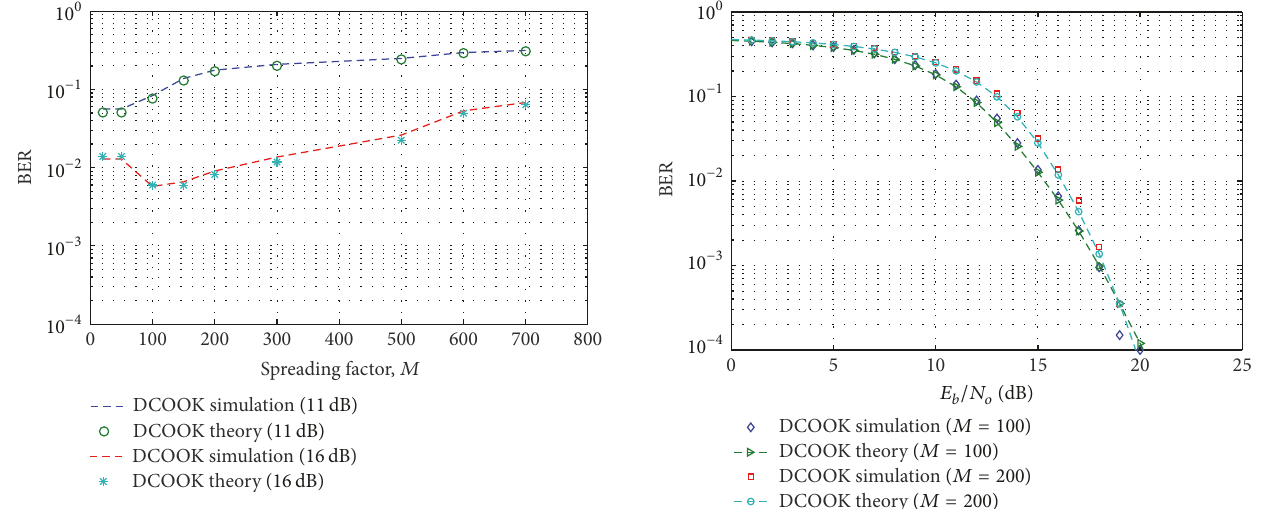
Figure 11: Simulated and theoretical BER performance of DCOOK at 𝑀 = 100 and 𝑀 = 200 .